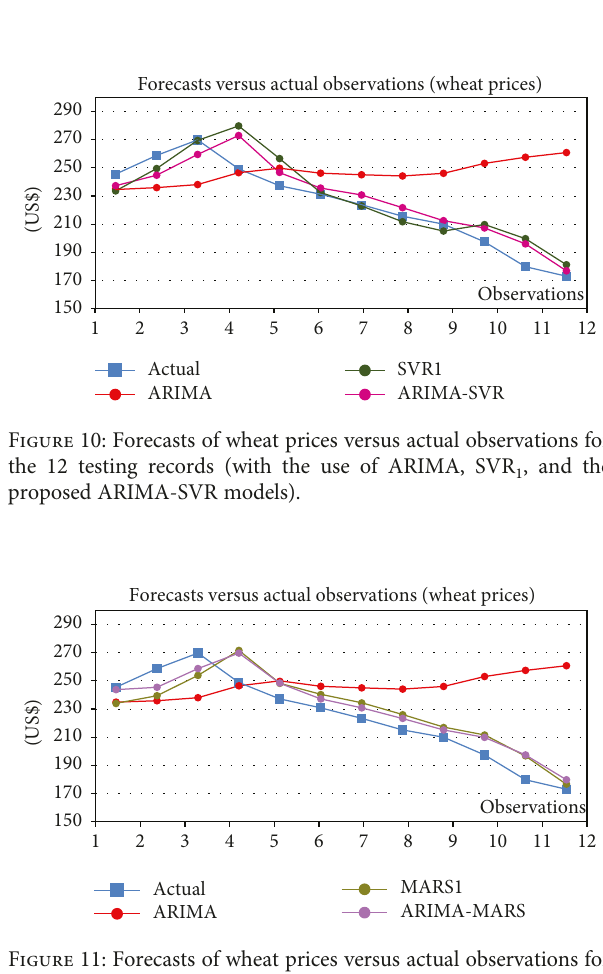
Figure 11: Forecasts of wheat prices versus actual observations for the 12 testing records (with the use of ARIMA, MARS proposed ARIMA-MARS models).